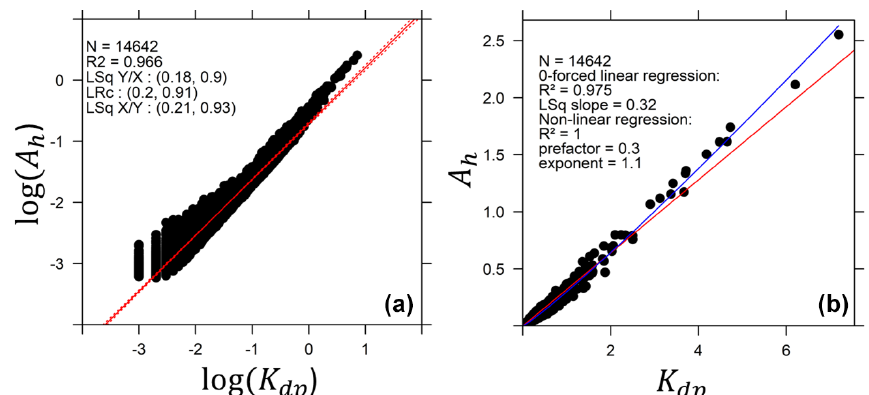
Figure 4. Fitting of DSD-derived power law models for the horizontal specific attenuation A h (dBkm − 1 ) as a function of the specific differential phase shift on propagation K dp ( ◦ km − 1 ) (a) using a classical logarithmic of base 10 transformation of the two variables (same comments as in Fig. 3 for this graph) and (b) using natural values of the two variables. The red line in panel (b) is the zero-forced linear regression with a slope equal to 0.32, and the blue curve is the non-linear fit of a power law model with a prefactor of 0.30 and an exponent of 1.1. b AZ , b AK and dC values listed in Table 1, i.e. 1 × 6 × 13 = 78